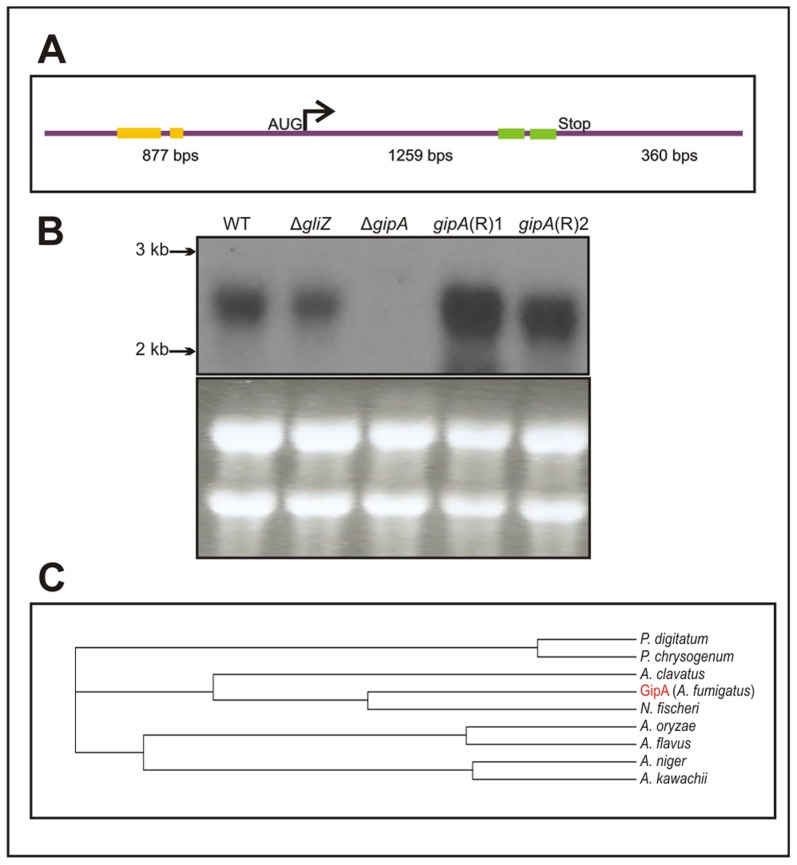
Characterization of gipA cDNA.(a) Schematic of cDNA size and composition. Yellow bars signify μORFs and the green bars display the two zinc finger domains. The size indicated for the coding region includes the one intron. (b) Northern hybridization of gipA from total RNA. WT is wild-type (Af1160) and (R) signifies complemented strains. (c) Cladogram of GipA homologues. N. fischeri is Neosartorya fischeri.